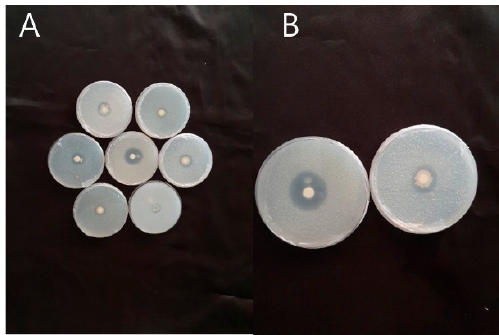
Figure 1. Detection of P. koreensis MU2 silicate and phosphate-solubilizing ability under salt-stress conditions. ( A ) Overall screening under different salt concentrations ( B ) presence of a halo-zone representing silicate and phosphate solubilization at a salt concentration of 300 mM.